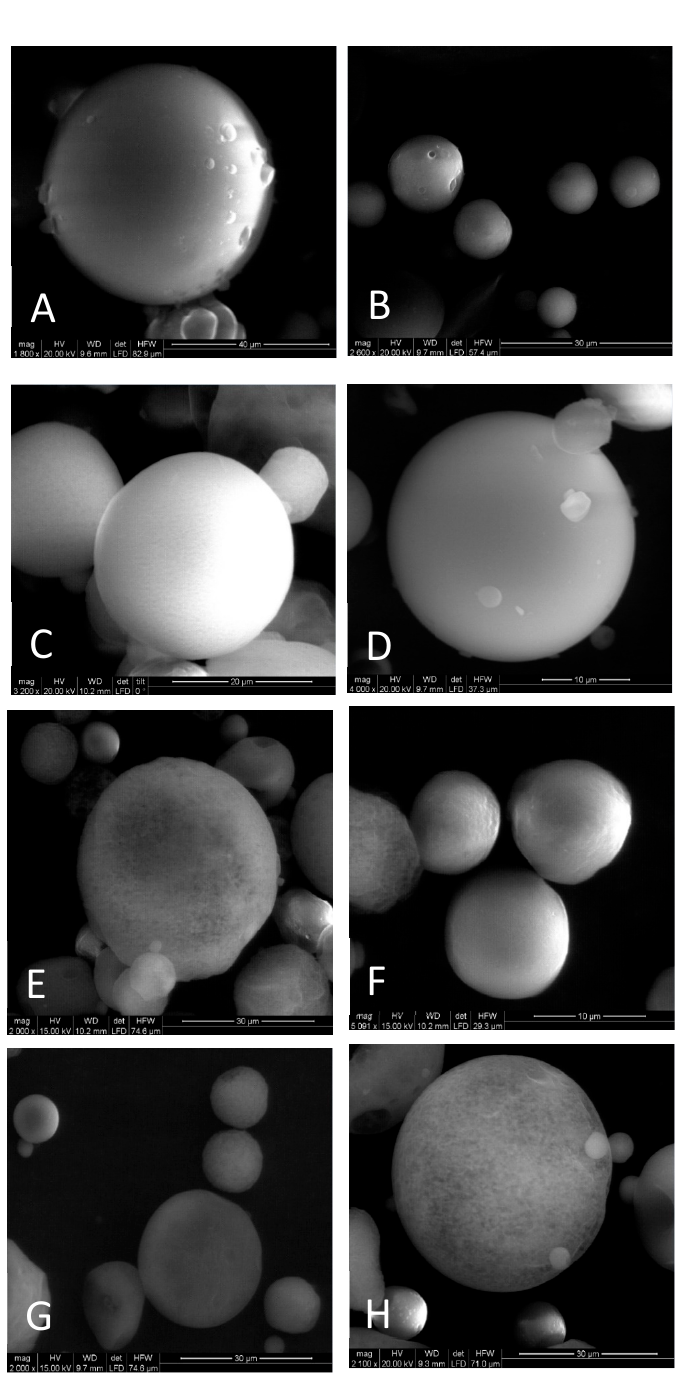
Figure 4. ESEM pictures of microcapsules prepared by VIPS technique. ( A – C ) VIPS 1; ( D – F ) VIPS 2; ( G , H ) VIPS 3.